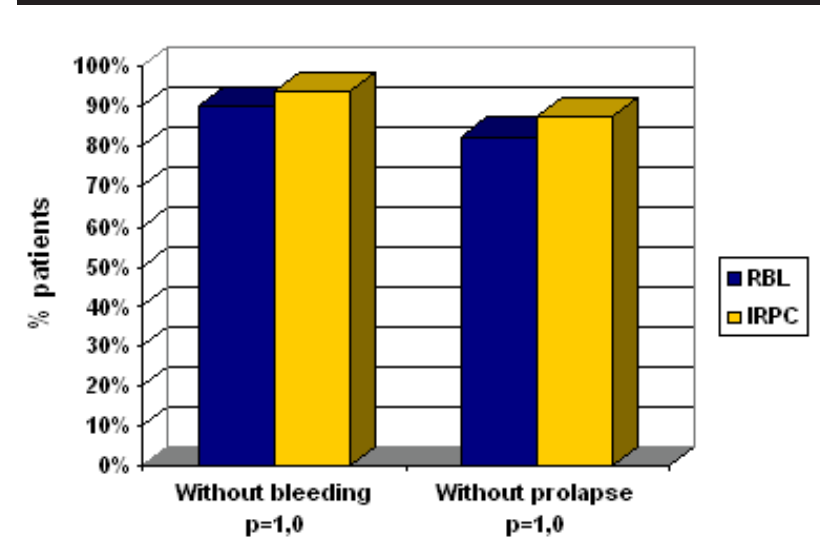
FIGURE 3 – Patients without bleeding and prolapse after procedures (percentages